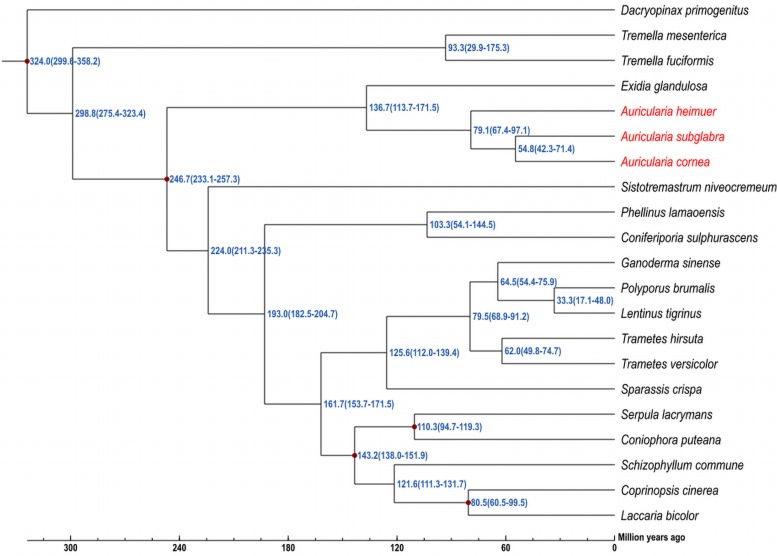
Phylogenomic analysis of 21 fungal genomes. The estimated divergence times are shown at the nodes, and the overall timeline is shown below the phylogenetic tree.